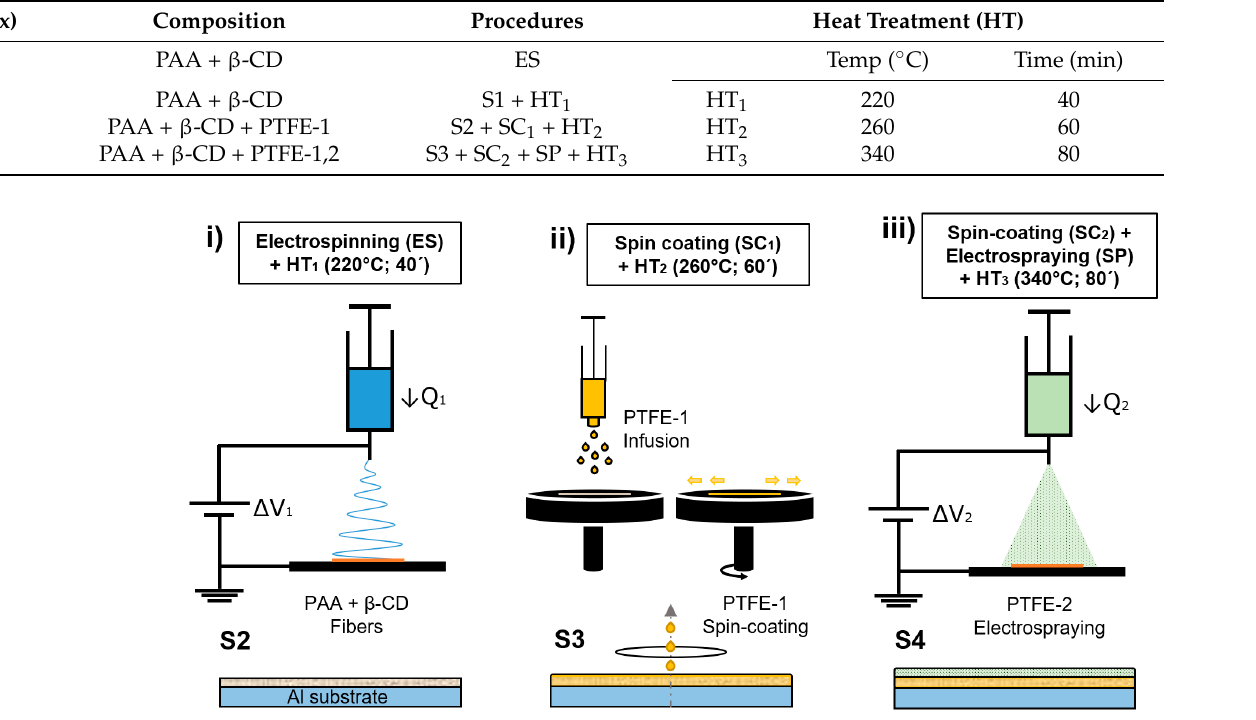
Figure 1. Schematic illustration of the fabrication methods to produce S2, S3, and S4 composite samples. ( i ) Electrospinning a PAA + β -CD fibrous coating and HT 1 . ( ii ) S2 + spin-coating with PTFE-1 dispersion and HT 2 . ( iii ) S3 + spin-coating with PTFE-1 dispersion, electrospraying with PTFE-2 dispersion and HT 3 .